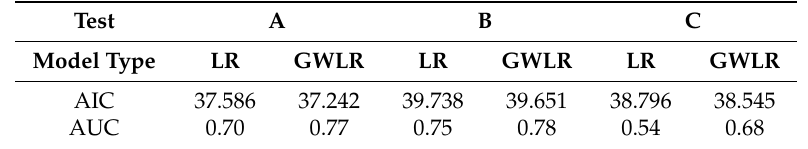
Table 3. Measures of model fit.